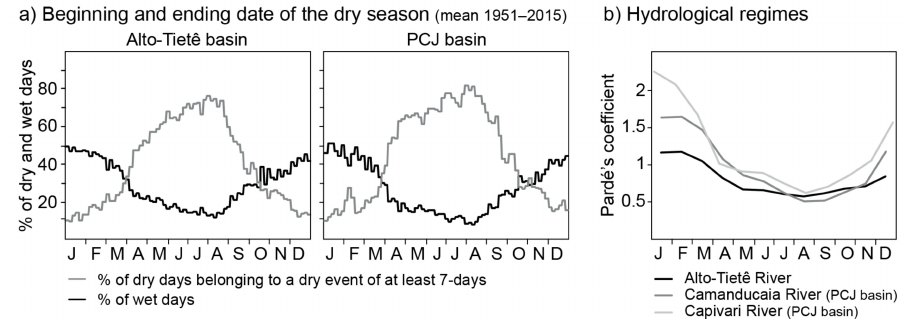
Figure 3. Mean seasonal pattern of ( a ) precipitation and ( b ) runoff in the Alto-Tiet ê basin and the headwaters of the Piracicaba-Capivari-Jundia í (PCJ) basin for the 1951–2015